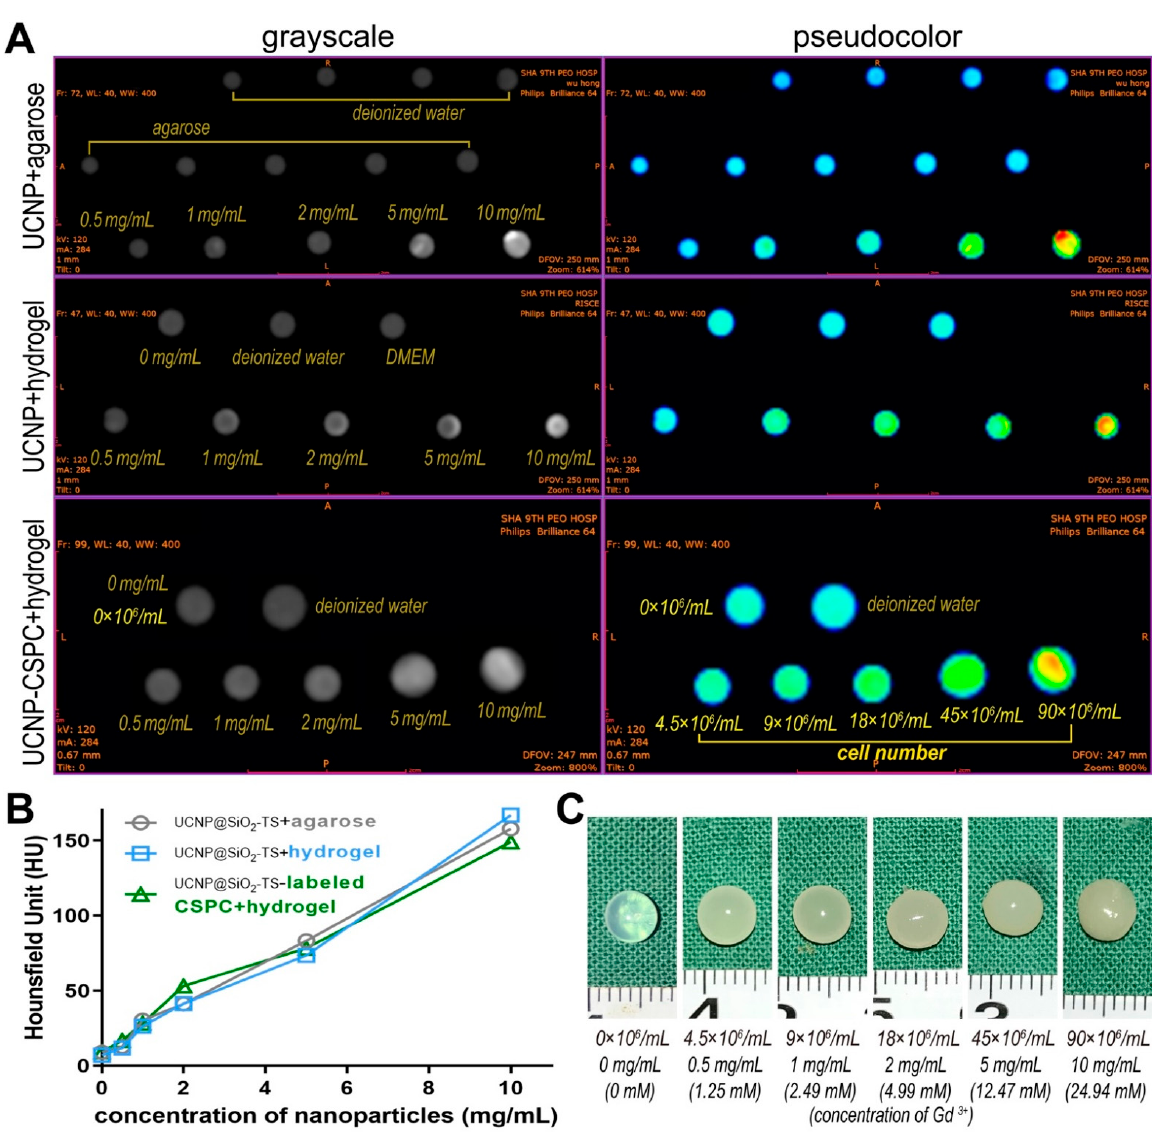
Figure 6. CT imaging of UCNP@SiO 2 -TS of increasing concentrations (0.5–10 mg/mL) and hydrogel constructs containing UCNP@SiO 2 -TS-labeled CSPCs of increasing numbers (4.5–90 × 10 6 cells/mL). ( A ) CT images of UCNP@SiO 2 -TS suspended in agarose, UCNP@SiO 2 -TS encapsulated in alginate hydrogel, and hydrogel constructs containing UCNP@SiO 2 -TS-labeled CSPCs, which contain identical relative concentrations of nanoparticles. Left column: the original images in grayscale mode; right column: images processed into pseudo-color mode. ( B ) CT values of the three groups. No significant difference exists between the three linear regression results ( p < 0.05, n = 3). ( C ) Gross view of the hydrogel constructs containing UCNP@SiO 2 -TS-labeled CSPCs examined by